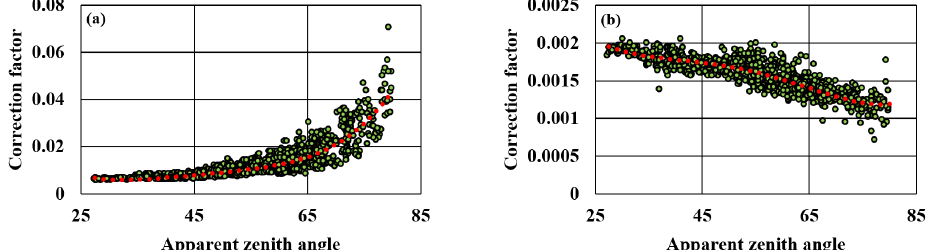
Figure 3. Correction factor for the elimination of the stray-light effect depending on the apparent zenith angle (a) for the wavelength of 306.3nm; (b) for the wavelength of 320nm.